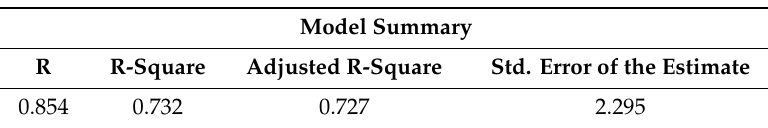
Table 6. Model summary.